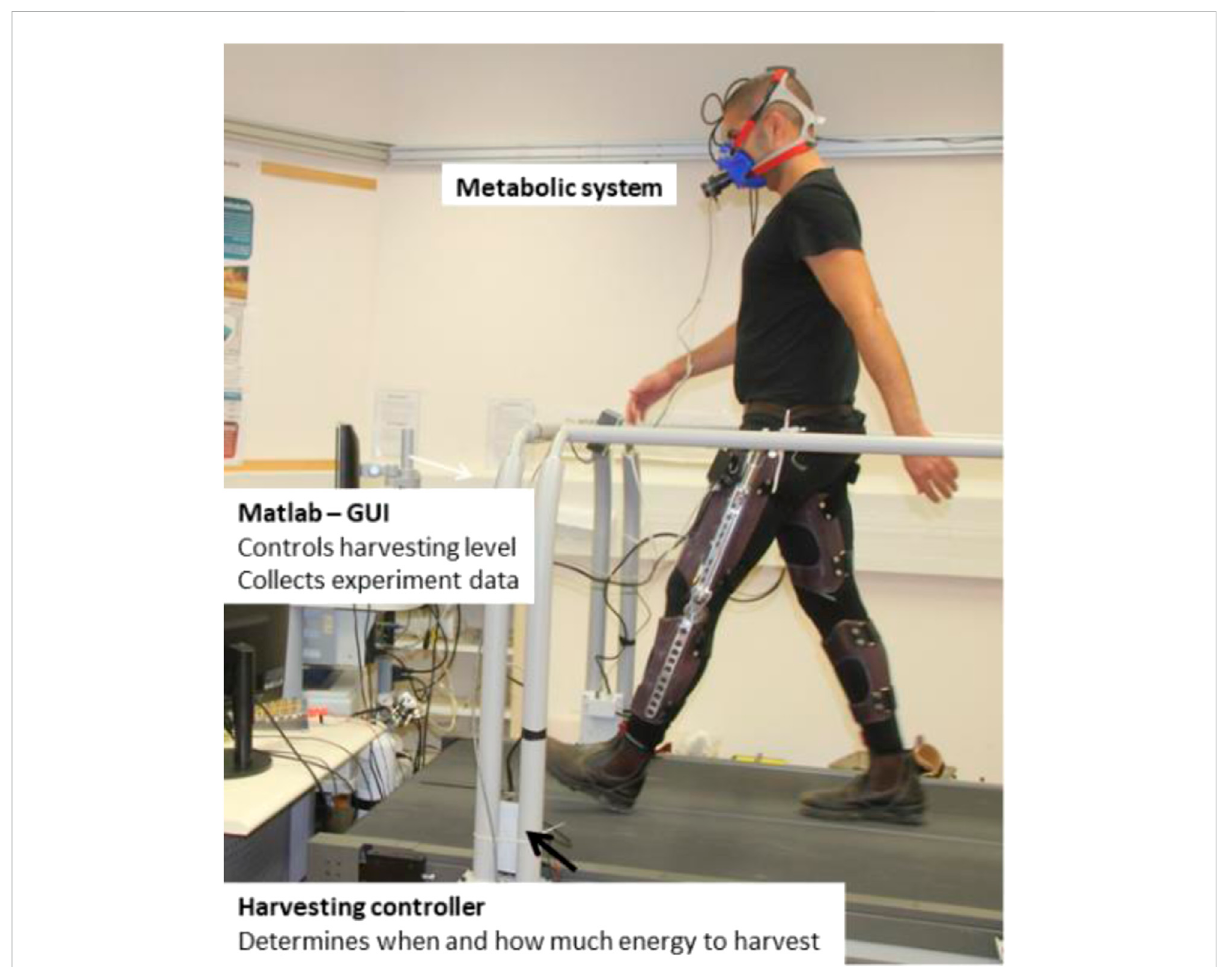
FIGURE 4 The experimental system included the Matlab graphical user interface (GUI), which sets the harvesting level and collects the experiment data; metabolic system;energyharvesterforeachleg;andharvestingcontrollerforeachleg,whichdetermineswhentoharvestandhowmuch(basedon the harvesting